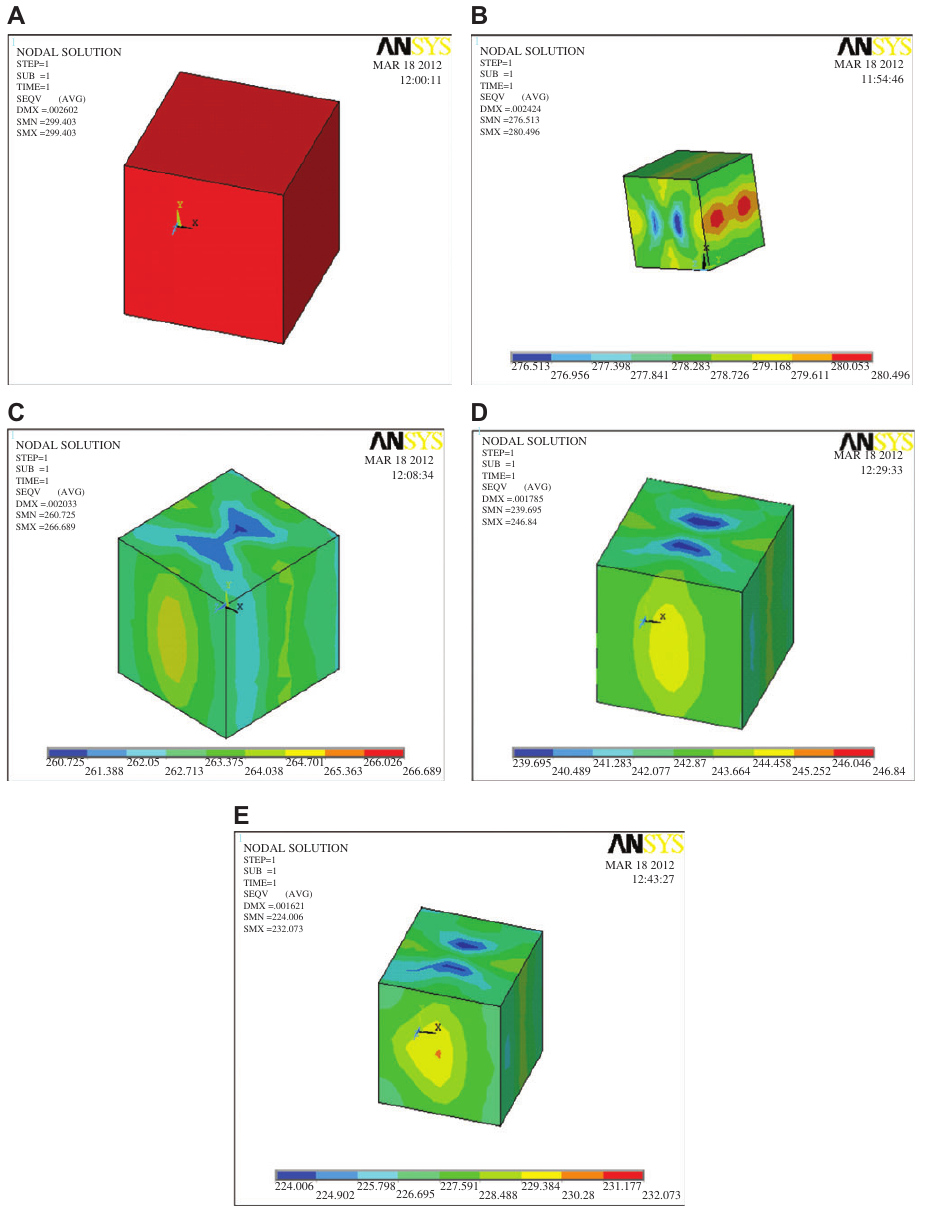
Figure 4 (A) Von-mises stress in 0 wt.- % micro-TiO alloy composites. (C) Von-mises stress in 4 wt.- % micro-TiO A384 alloy composites. (E) Von-mises stress in 8 wt.- % micro-TiO